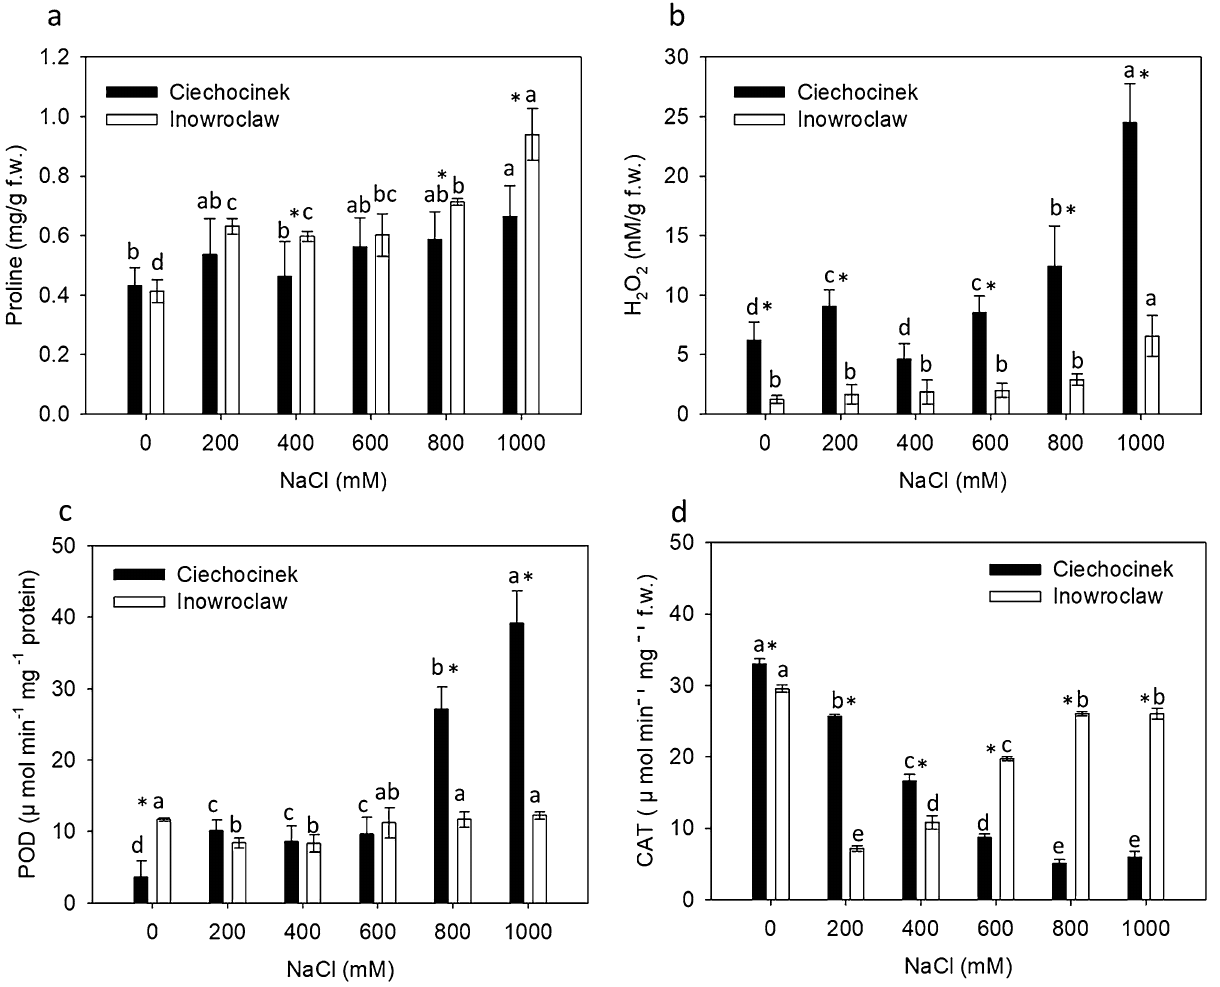
Figure 3. ( a ) Proline, ( b ) hydrogen peroxide contents, and specific enzyme activities of ( c ) POD and ( d ) CAT in S. europaea populations (Inowrocław and Ciechocinek) under NaCl stress. Means and ± SD of replicates. Different letters indicate significant differences between treatments within population and * indicates significant difference between populations within treatment ( p < 0.05), n = 3. The F values that correspond to the 2-way ANOVA for the interaction of salt treatment × population are F 5,24 = 2.3, F 5,24 = 8.1, F 5,24 = 54.5 and F 5,24 = 35.9 for proline, hydrogen peroxide, POD and CAT respectively with a p <